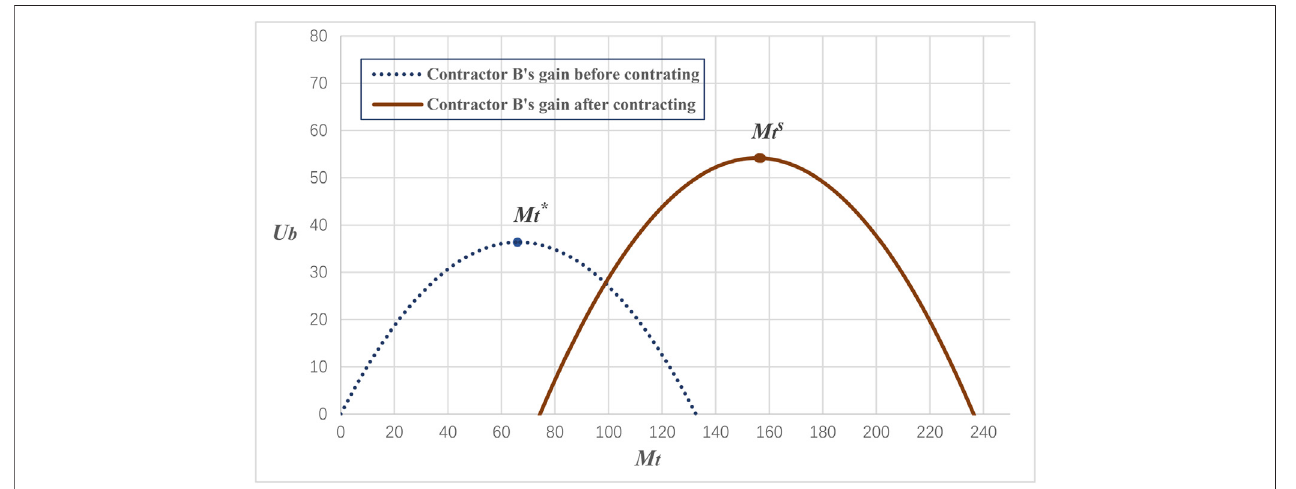
FIGURE 4 | The noncritical contractor ’ s gain function before and after contracting in Scenario I.